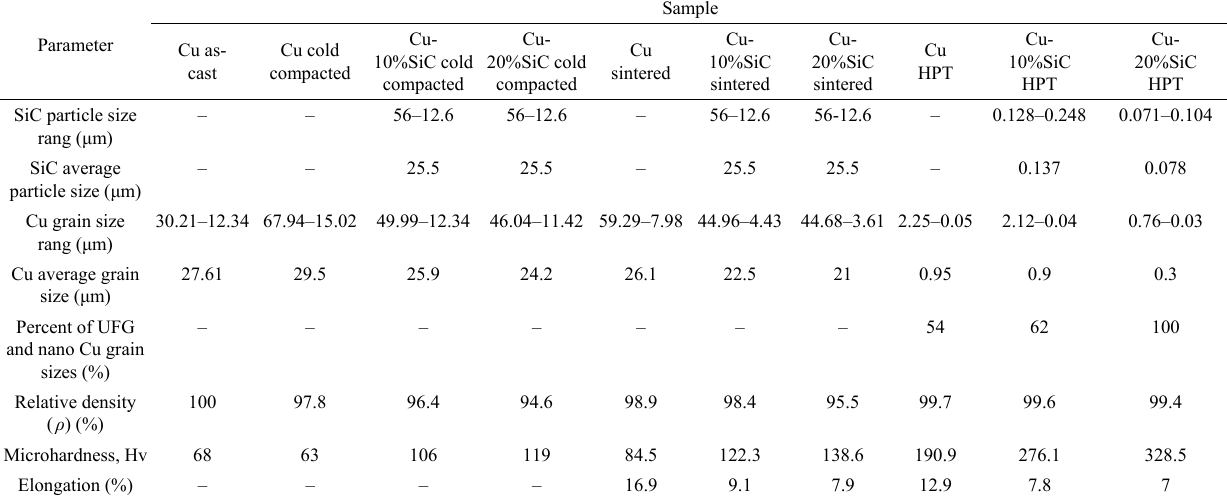
Table 1 Summary of microstructure, relative density, and mechanical properties parameters of the different samples [23].